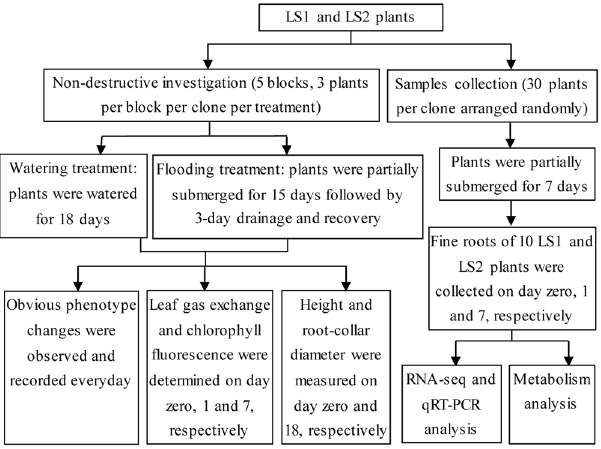
Figure 7. Experiment design drawing of the